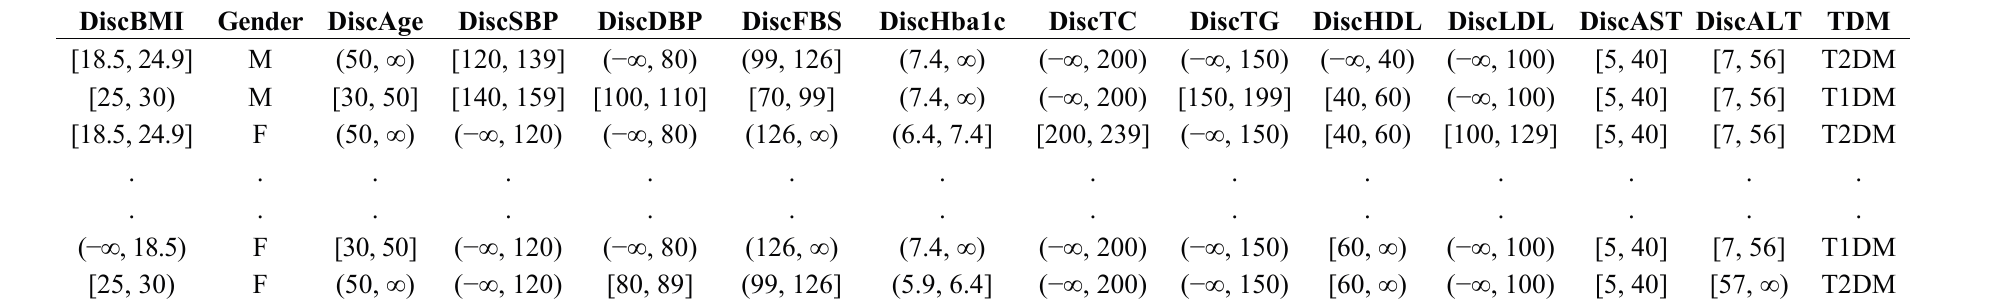
Table 6. Partial data of diabetes mellitus Information System in interval format after discretization.